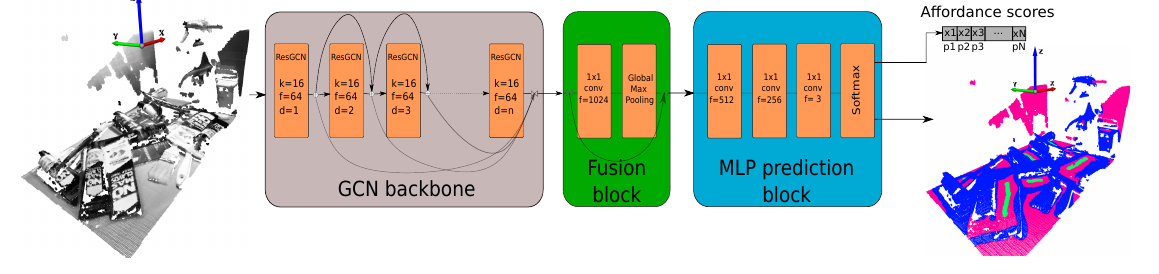
Figure 9. Used model